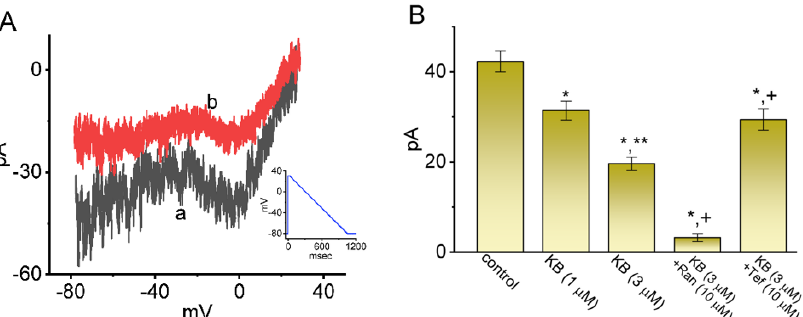
Figure 6. Inhibitory effect of KB − 7943 on instantaneous resurgent Na + current ( I Na(R) ) identified from GH 3 cells. The experiments used to evoke non-linear I Na(R) were designed to consist of a conditioning pulse step from − 80 to +30 mV with a duration of 30 ms followed by a 1 s descending V ramp from +30 to − 80 mV (i.e., ramp pulse of − 0.11 mV/ms). ( A ) Exemplar relationship of the current amplitude versus the membrane potential taken in the control period (a, black color) and during exposure to 3 μM KB − 7943 (b, red color). Inset shows the voltage clamp protocol applied. ( B ) Summary graph disclosing effects of KB − 7943 (KB, 1 or 3 M), KB − 7943 plus ranolazine (Ran), and KB − 7943 plus tefluthrin (Tef) on the amplitude of I Na(R) in response to the descending (repolarizing) V ramp (mean ± SEM; n = 7 for each yellow bar). Each current amplitude evoked by the downsloping V ramp was taken at the level of −5 mV. * Significantly different from control ( p < 0.05), ** significantly different from KB- 7943 (1 μM) alone group ( p < 0.05), and + significantly different from KB − 7943 (3 μM) alone group ( p < 0.05).